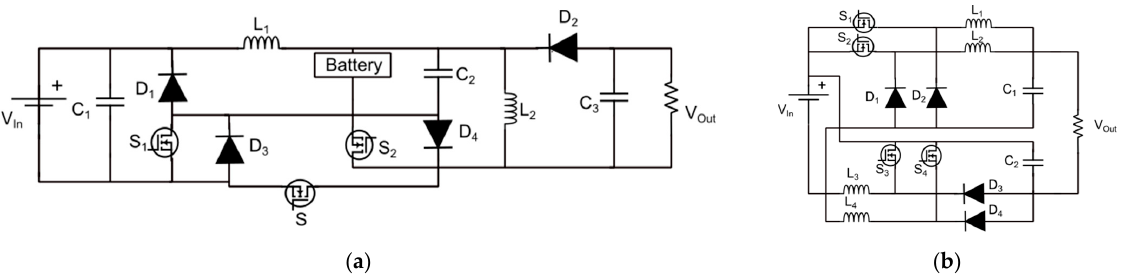
Figure 10. Fault-tolerant buck/buck-boost converter (FTbbB) ( a ). Interleaved step-up/step-down converter (ISUSD) ( b ).